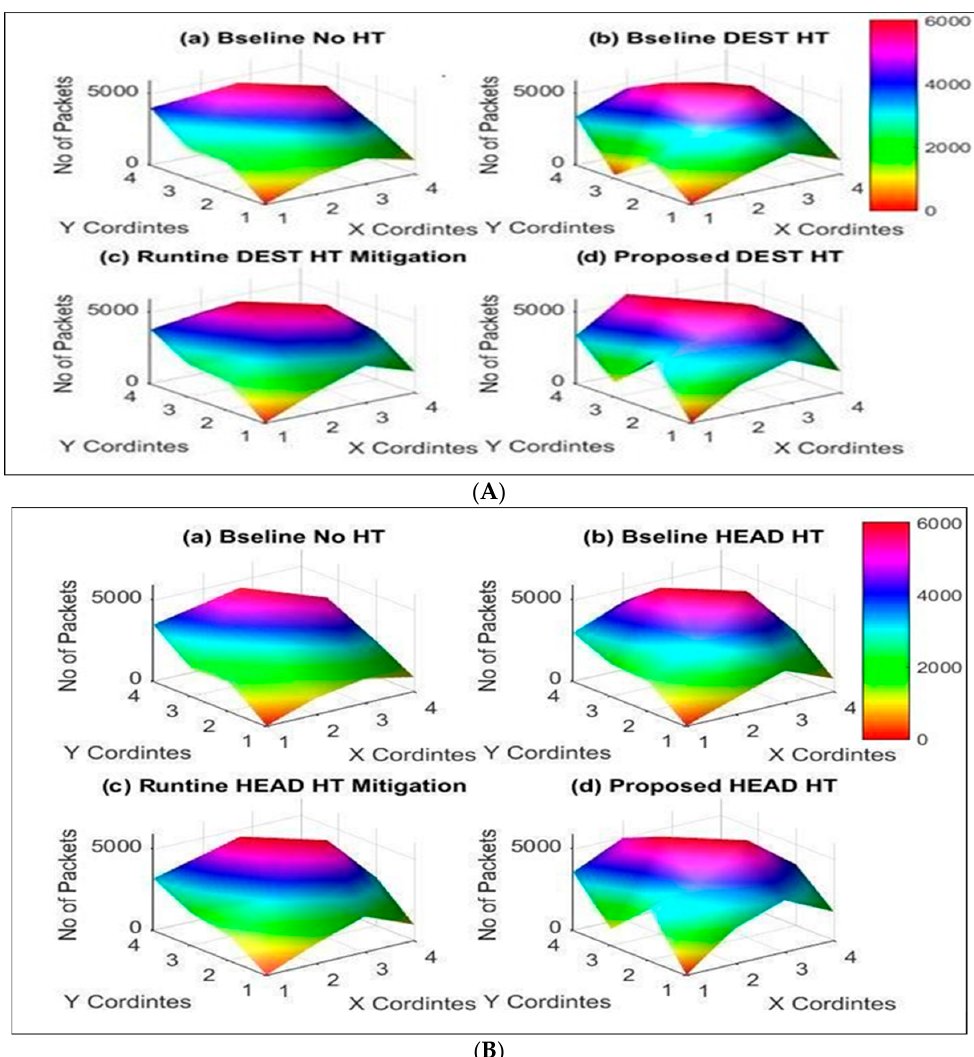
Figure 12. ( A ) The effect of destination HTs on traffic hotspot migration and bandwidth depletion. ( B ) The effect of destination HTs on traffic hotspot migration and bandwidth depletion.